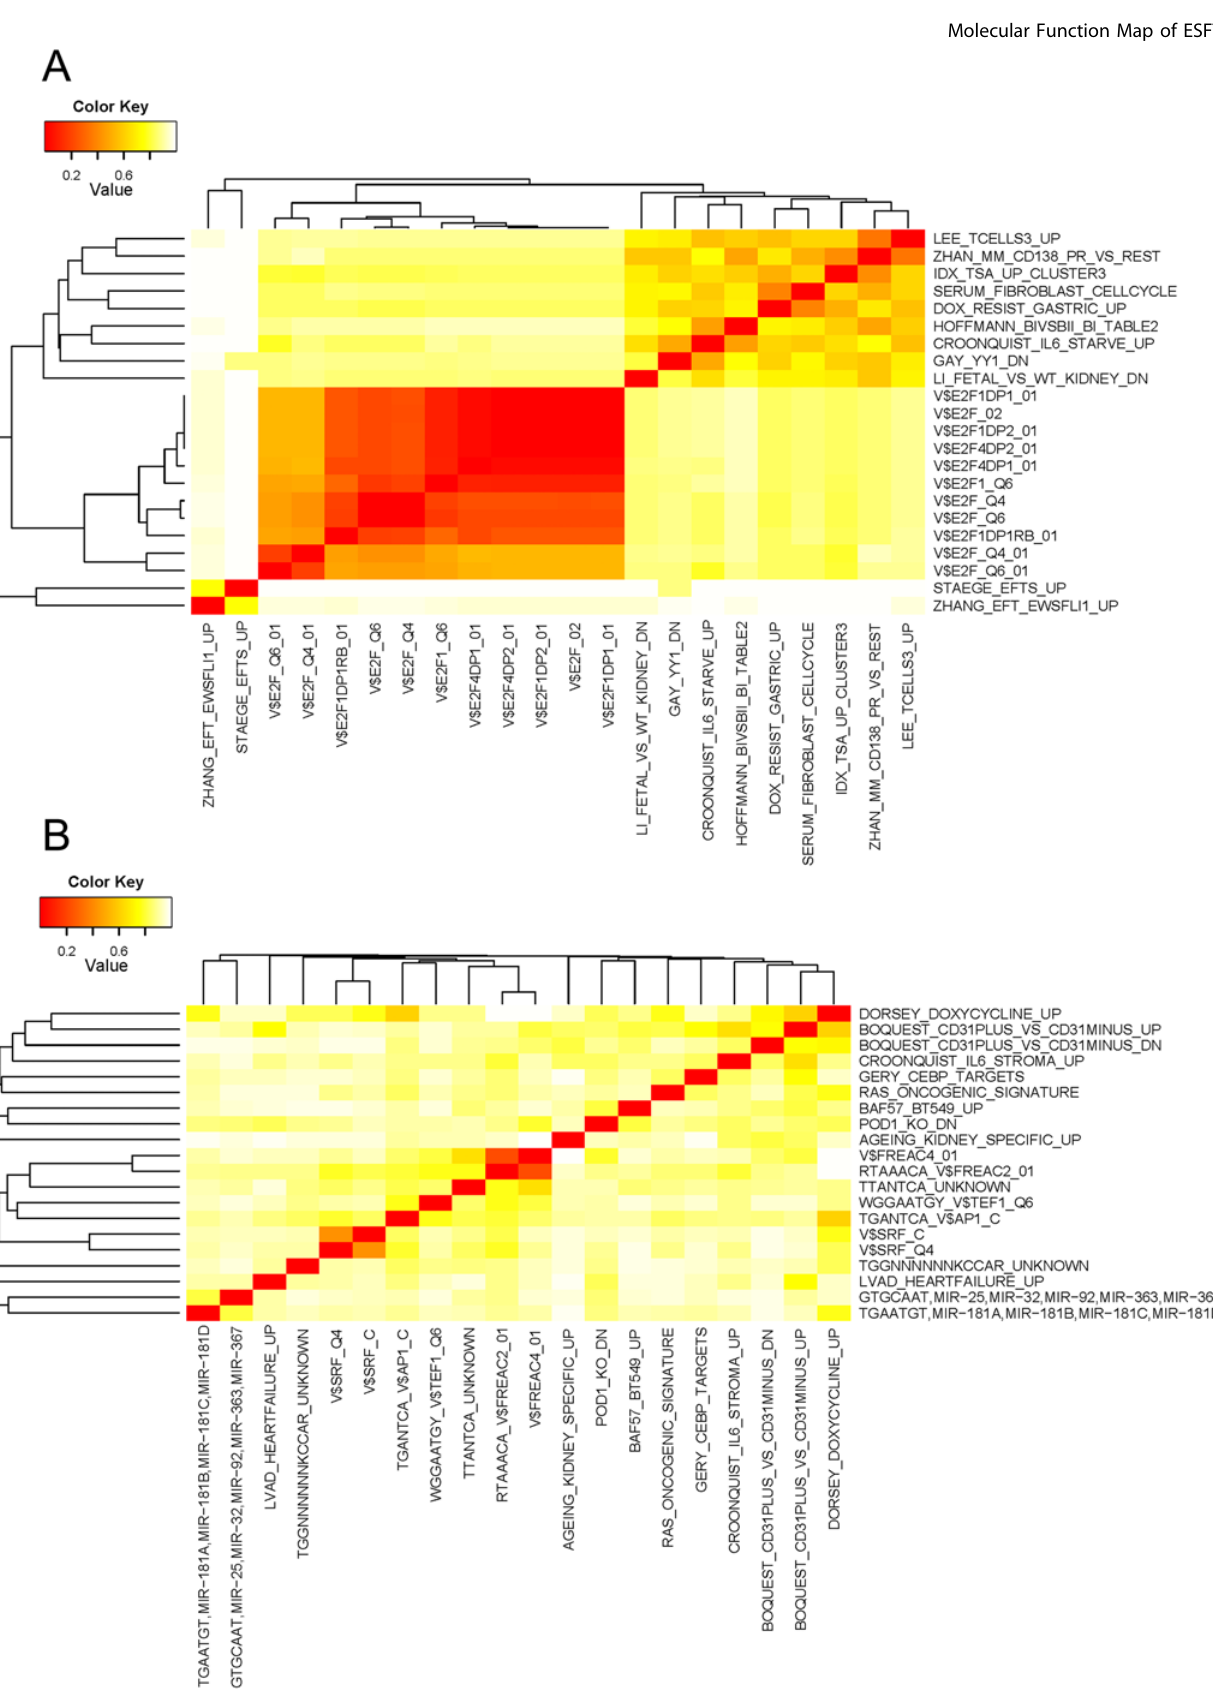
Figure 4. Significant MSigDB gene sets. Significant MSigDB gene sets (c2, c3) from the pGSEA analysis were aggregated by hierarchical clustering. A: Gene sets significantly overlapping EWS-FLI1 upregulated genes, B: Gene sets significantly overlapping EWS-FLI1 downregulated genes. doi:10.1371/journal.pone.0005415.g004 PLoS ONE |